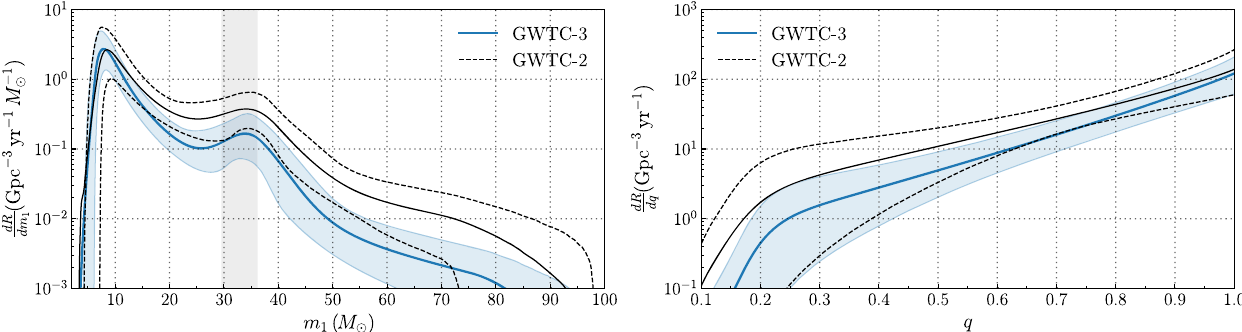
FIG. 10. The astrophysical BBH primary mass (left) and mass ratio (right) distributions for the fiducial PP model, showing the differential merger rate as a function of primary mass or mass ratio. The solid blue curve shows the posterior population distribution (PPD) with the shaded region showing the 90% credible interval. The black solid and dashed lines show the PPD and 90% credible interval from analyzing GWTC-2 [20]. The vertical gray band in the primary mass plot shows 90% credible intervals on the location of the mean of the Gaussian peak for the fiducial